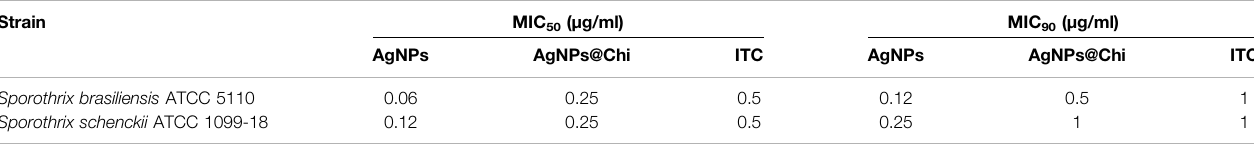
TABLE 1 | Inhibitory activity of silver nanocomposites against Sporothrix spp.